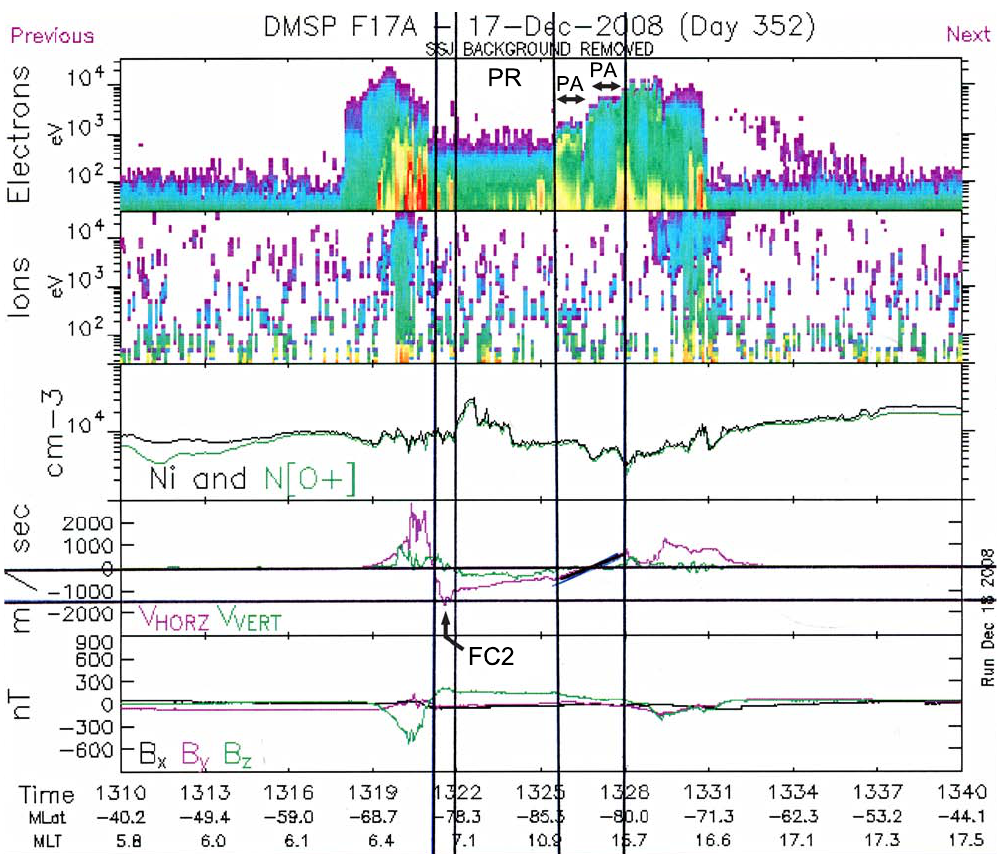
Fig. 8. DMSP F17 Southern Hemisphere data for the interval 13:10–13:40UT on 17 December 2008. Same format as in Fig. 7. Flow channel FC 2 of category SH-dawn/ B y < 0 is marked. Polar arcs (PA) are located in region of flow shear (ion drift gradient) marked between the third and the fourth